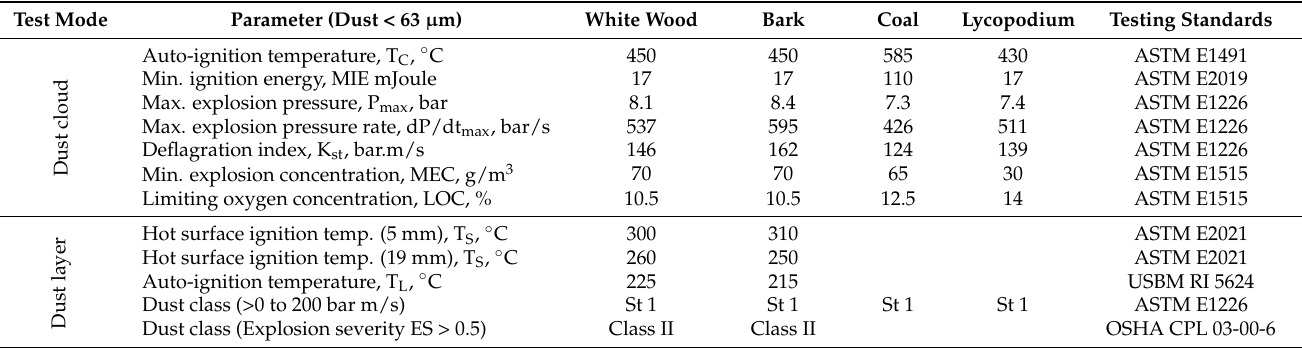
Table 6. Fire and explosion parameters for wood, coal, and Lycopodium 1 particles (adapted from [19]).